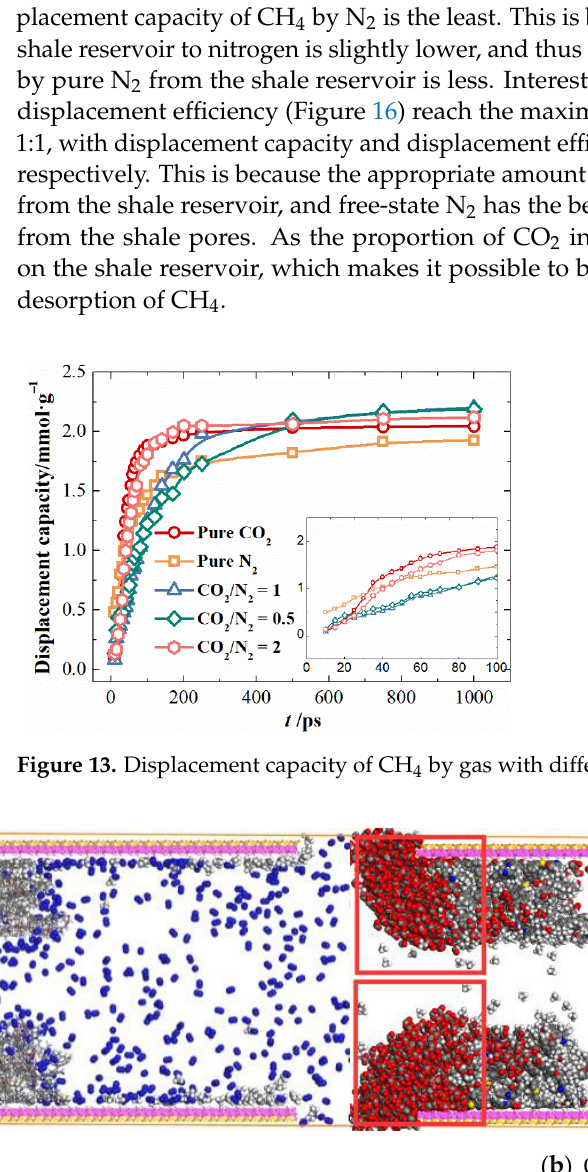
Figure 14. The simulated snapshots of the displacement process of CH 4 by injection gas: ( a ) N 2 ; ( b ) CO 2 .